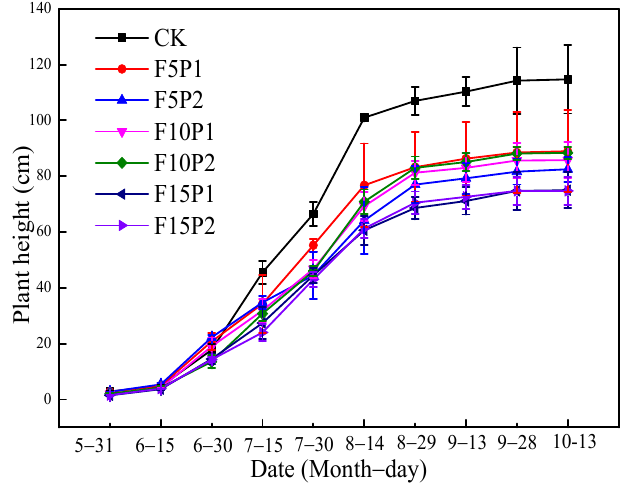
Figure 3. Effects of CSL on plant height of Artemisia ordosica .